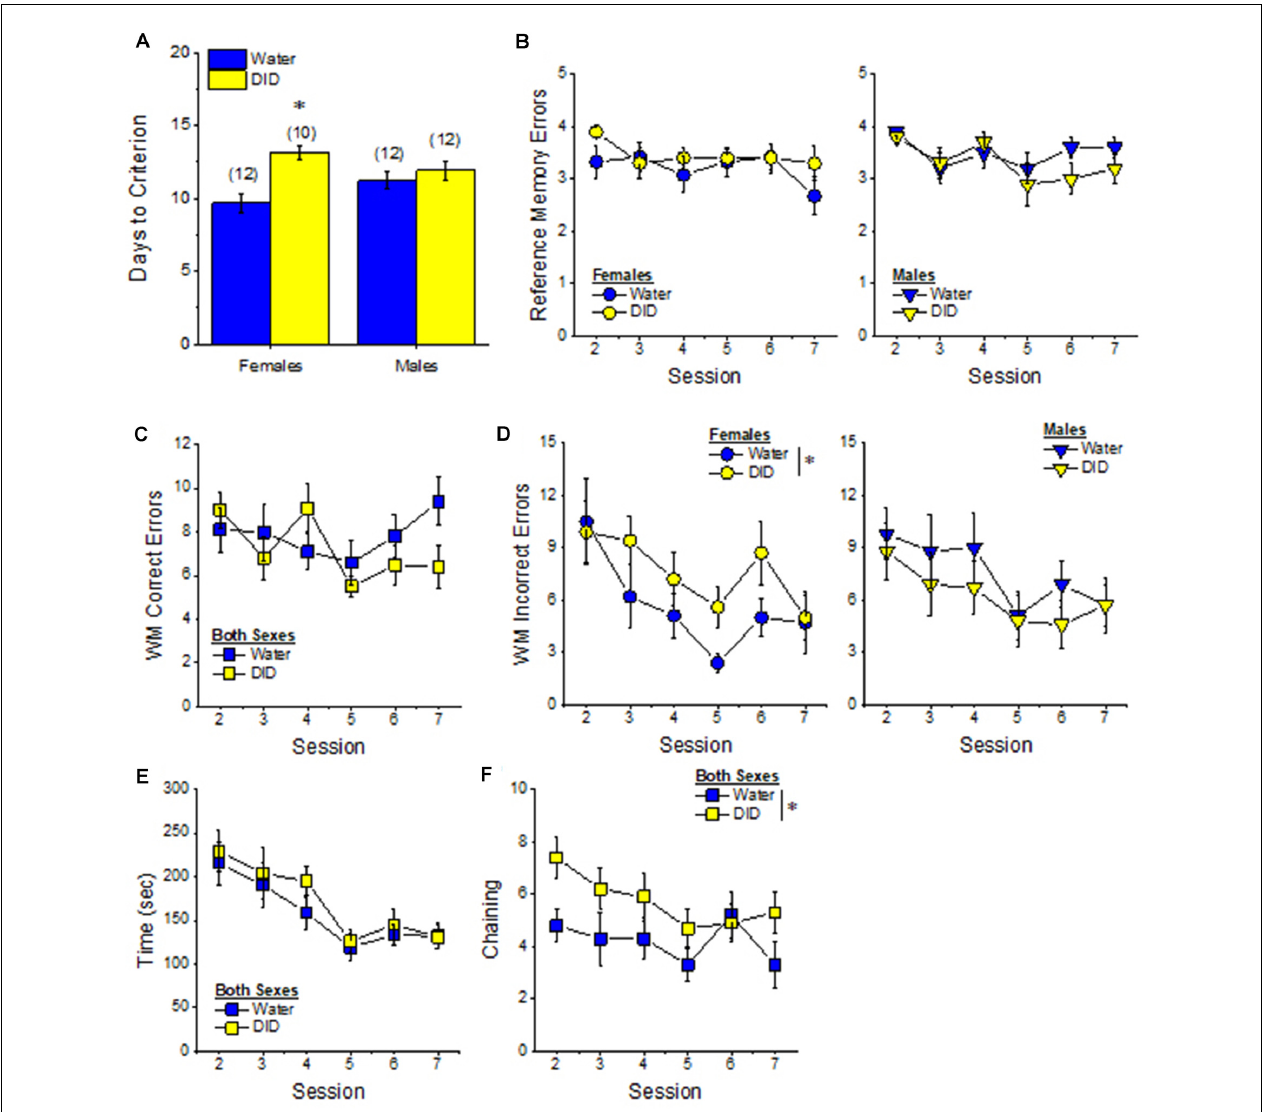
FIGURE 7 | Effects of binge drinking during later maturity (6 months of age) on radial arm maze performance in cohorts of isogenic C57BL/6J mice. (A) The binge drinking (DID) female C57BL/6J mice in Experiment 2 required more time than their water-drinking (Water) controls to reach asymptotic performance in the radial arm maze. No significant effect of binge drinking was detected for the number of reference memory errors (B) , or working memory (WM) correct errors (C) committed over the first week of radial arm maze training. Female DID mice committed more WM incorrect errors than their Water controls (D) , but we detected no group differences in the time taken to navigate the maze (E) . (F) Finally, the DID mice in Experiment 2 exhibited more chaining, on average, than Water mice. The data represent the means ± SEMs of the number of mice indicated in parentheses in Panel (A) . ∗ p < 0.05 DID vs. Water.